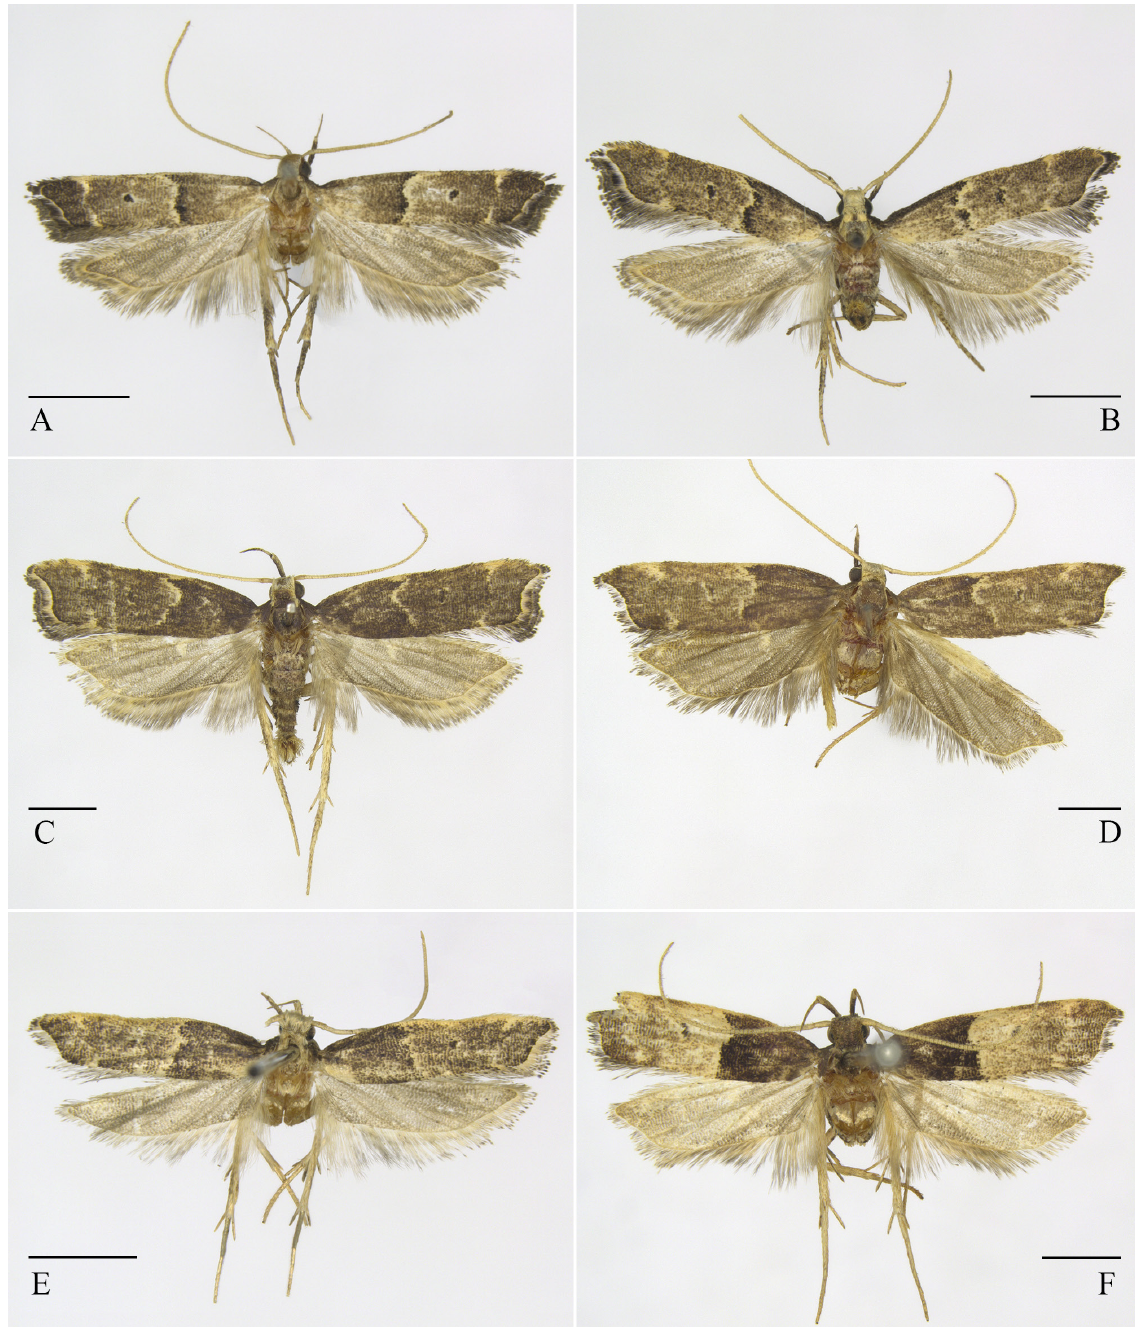
Fig. 1. Adults of Antiochtha spp. (dorsal view). A . A. erromera sp. nov., holotype (NKU). B . A. hainanensis sp. nov., paratype (NKU). C . A. jianfengensis Zhu & Li, 2009, from Hainan, China. D . A. jianfengensis , holotype of A. rotunda syn. nov. from Guizhou, China. E . A. miniscula sp. nov., holotype. F . A. semialis Park, 2002. Scale bars = 2.0